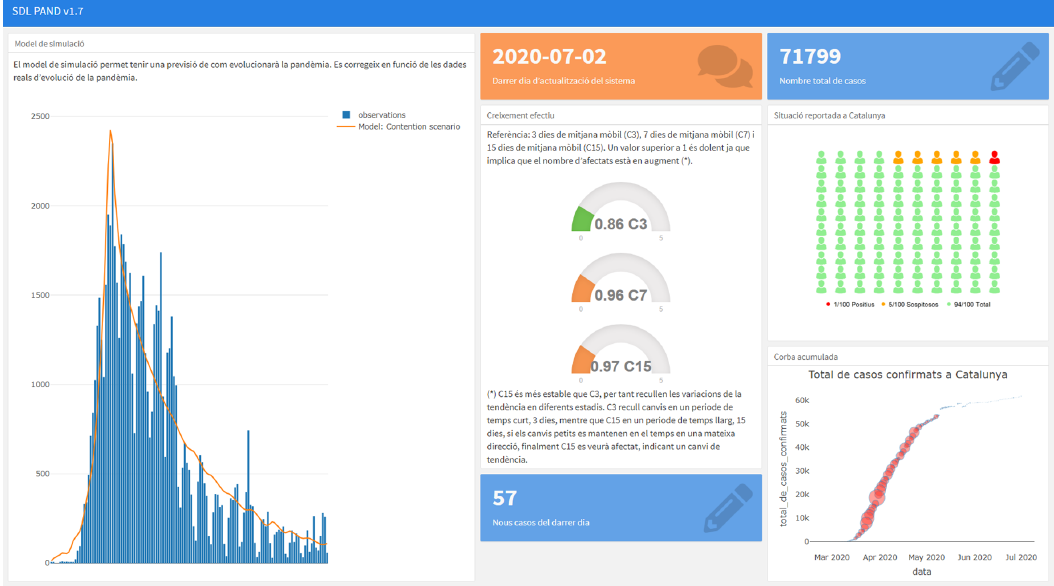
Figure 15. Prevision and Key Performance Indicators (KPI) of the status of the pandemic situation in Catalonia until July 2, 2020.